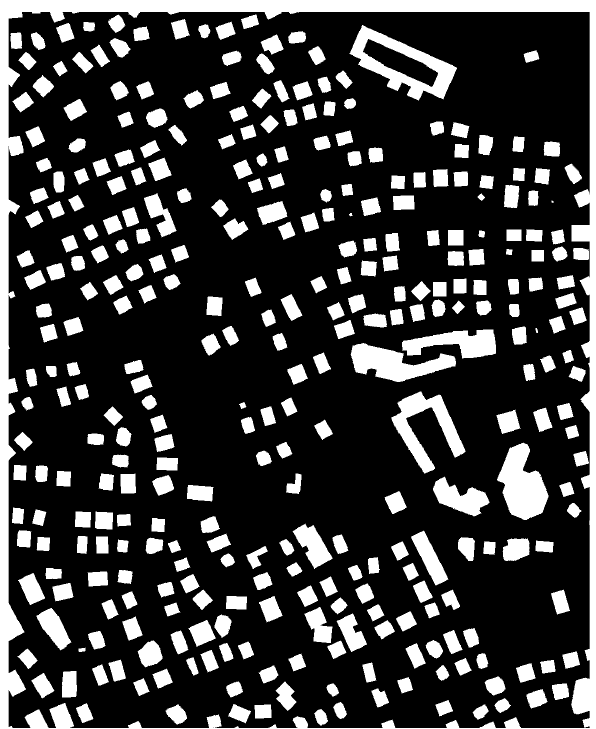
Figure 9: Approximation result (Binary regions) (in detail view)